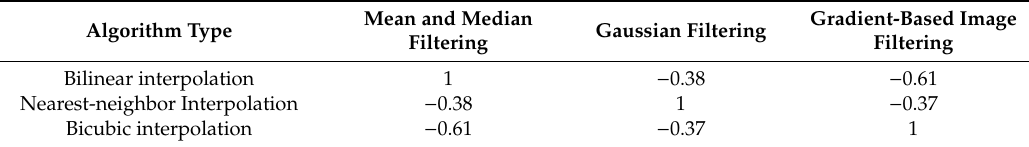
Table A15. The Pearson correlation coe ffi cients of the di ff erent image pyramid methods using FID. It confirms that our sample accuracy was